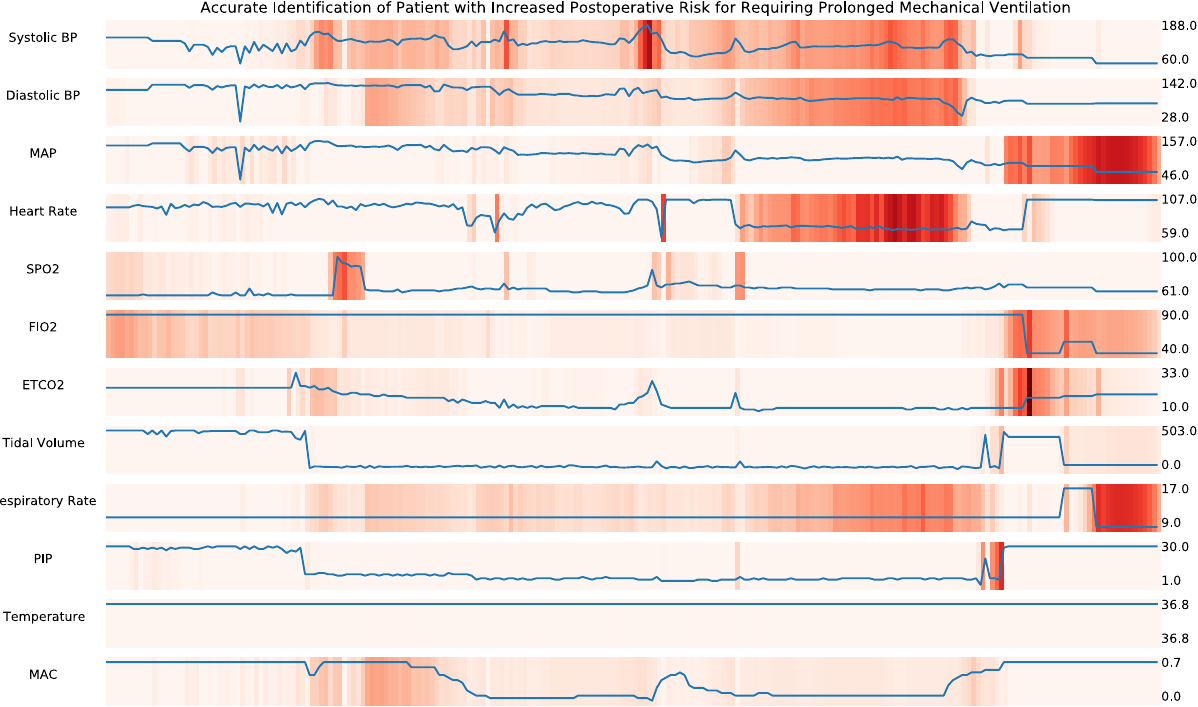
Figure 2. Temporal integrated gradients feature attributions for example patient experiencing prolonged mechanical ventilation. The multi-task deep learning model correctly predicted elevated risk of prolonged mechanical ventilation after integrating multivariate intraoperative time series. Physiological time series labeled by variable (left) and value range (right). Implementation of integrated gradients highlighted physiological patterns important for updated risk prediction, including a rapid increase in heart rate and ETCO2, fluctuations in PIP, and changes in SPO2. ETCO2, end-tidal carbon dioxide; PIP, peak inspiratory pressure; SPO2, blood oxygen